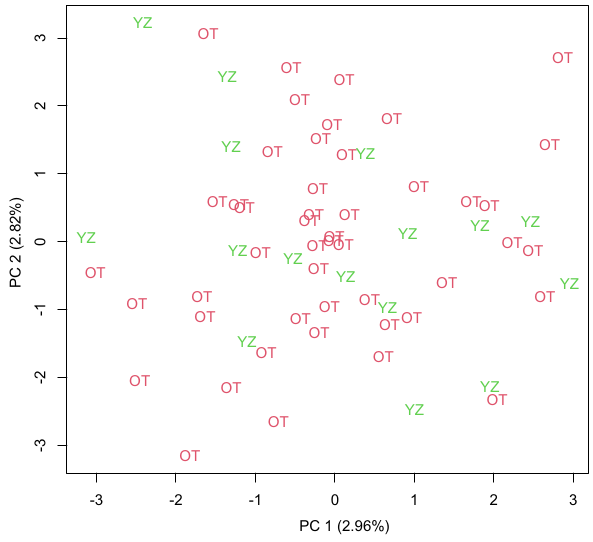
Figure 3. Plot of 1st and 2nd axes of principal component analysis based on a matrix of individual genotype frequencies of Simenchelys parasitica . Abbreviations; Okinawa Trough (OT), Suruga Bay (YZ).